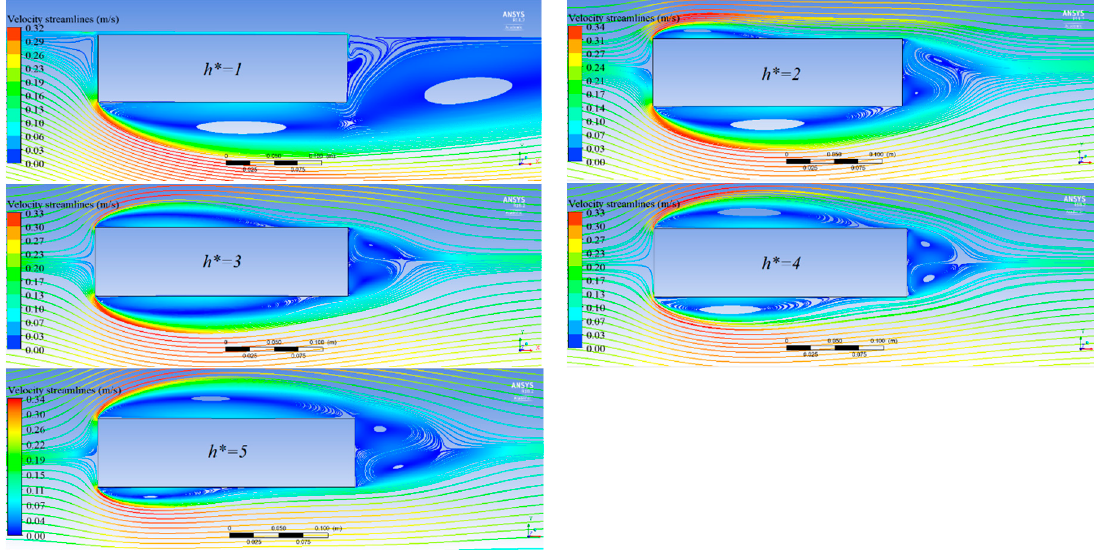
Figure 21. Streamlines of mean velocities around the deck for different inundation ratios, Fr s = 0.24.